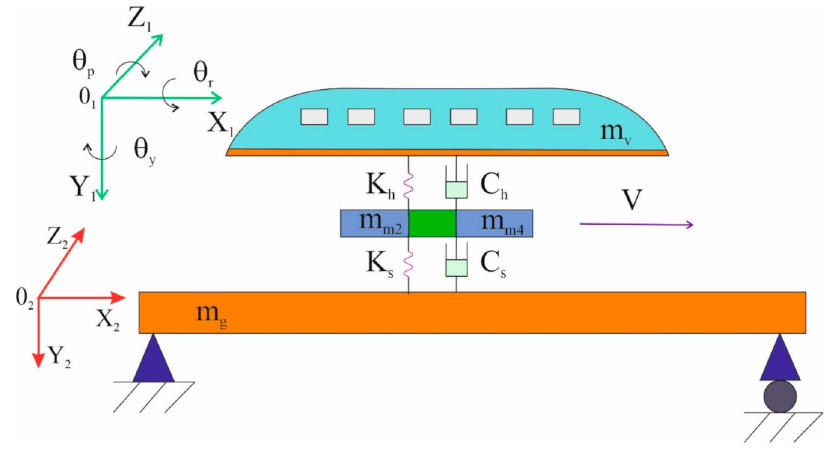
Figure 3. Discrete mechanical model of the Hyperloop vehicle in horizontal movement.